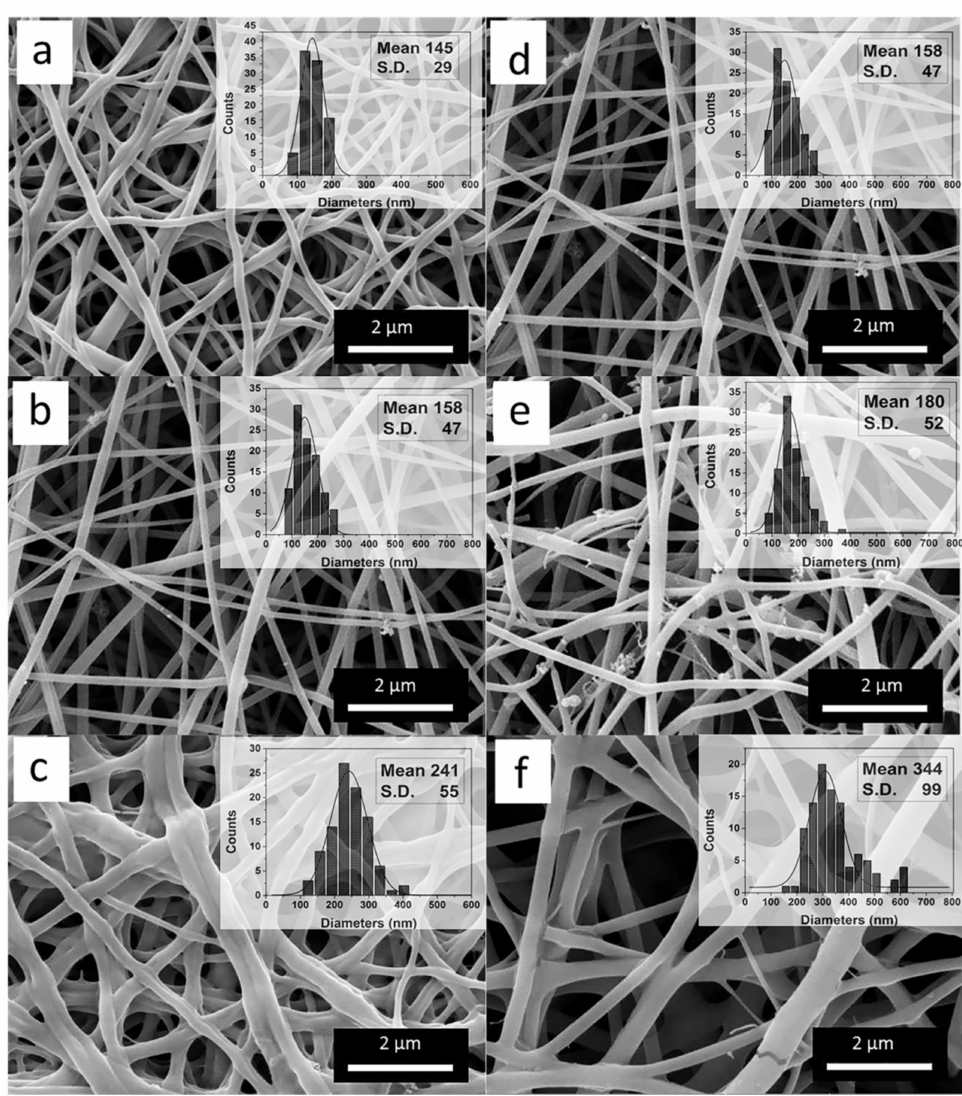
Figure 2. SEM images of SF nanofibers from different SF/CaCl 2 /FA spinning dopes. ( a – c ) the concentration of CaCl 2 was 3, 5, and 8 ( w/v ) %, respectively, when the concentration of SF is 15 ( w/v )%, ( d – f ) the concentration of SF was 15, 20, and 25 ( w/v ) %, respectively, when the concentration of CaCl 2 was 5 ( w/v ) %. The insert graphs were the diameter distribution of SF